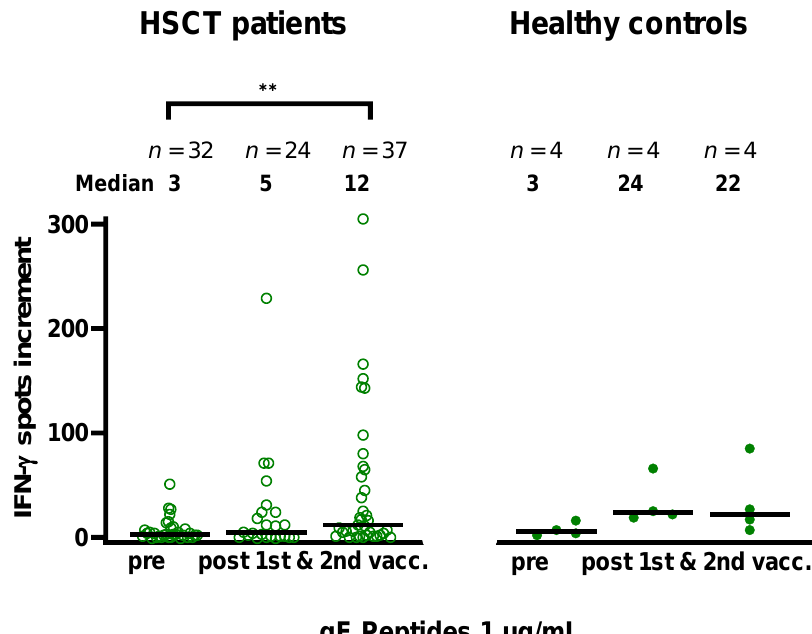
Figure 4. Varicella-zoster virus-specific ELISpot responses in hematopoietic stem cell transplant (HSCT) recipients (open circles) and healthy (filled circles) prior to and after the first and second vaccination with Shingrix™. Cells were stimulated with a peptide pool of glycoprotein E (gE) from JPT, used at concentrations of 1 µ g/mL per peptide. Blood sampling in patients was performed at a median of 38 months after transplantation. VZV-specific spots were determined as stimulated minus non-stimulated (background) values (spots increment). Horizontal lines represent median values. Data in patients were compared by one-way ANOVA with Turkey’s multiple comparisons test. ** p < 0.005.